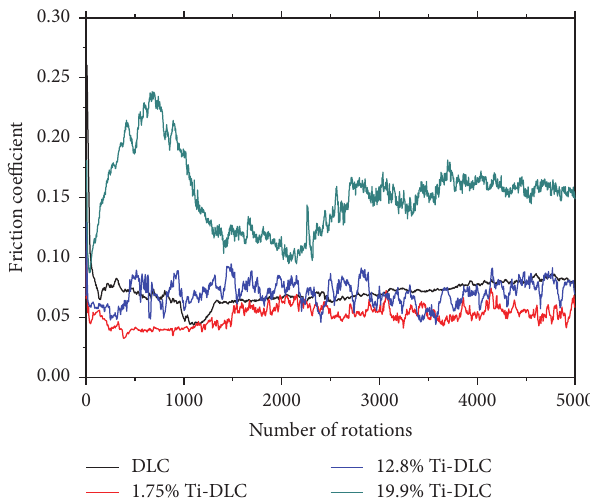
Figure 7: Electrical resistivity of Ti-DLC and Cu-DLC films as a function of the carbon content.